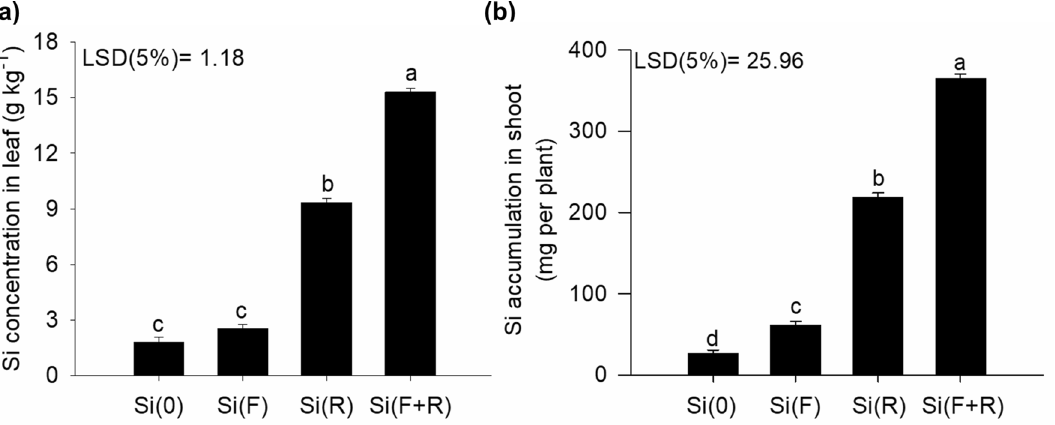
Figure 1. Concentration of Si in the leaves ( a ) and Si accumulation in shoots ( b ) of quinoa plants, according to different forms of Si application; no Si [Si(0)]; foliar Si application [Si(F)]; root Si application [Si(R)]; combination between root and foliar application [Si(F + R)]. Letters indicate significant differences between the forms of Si application (p < 0.05); least significant difference [LSD]. The vertical bars represent the standard error of the